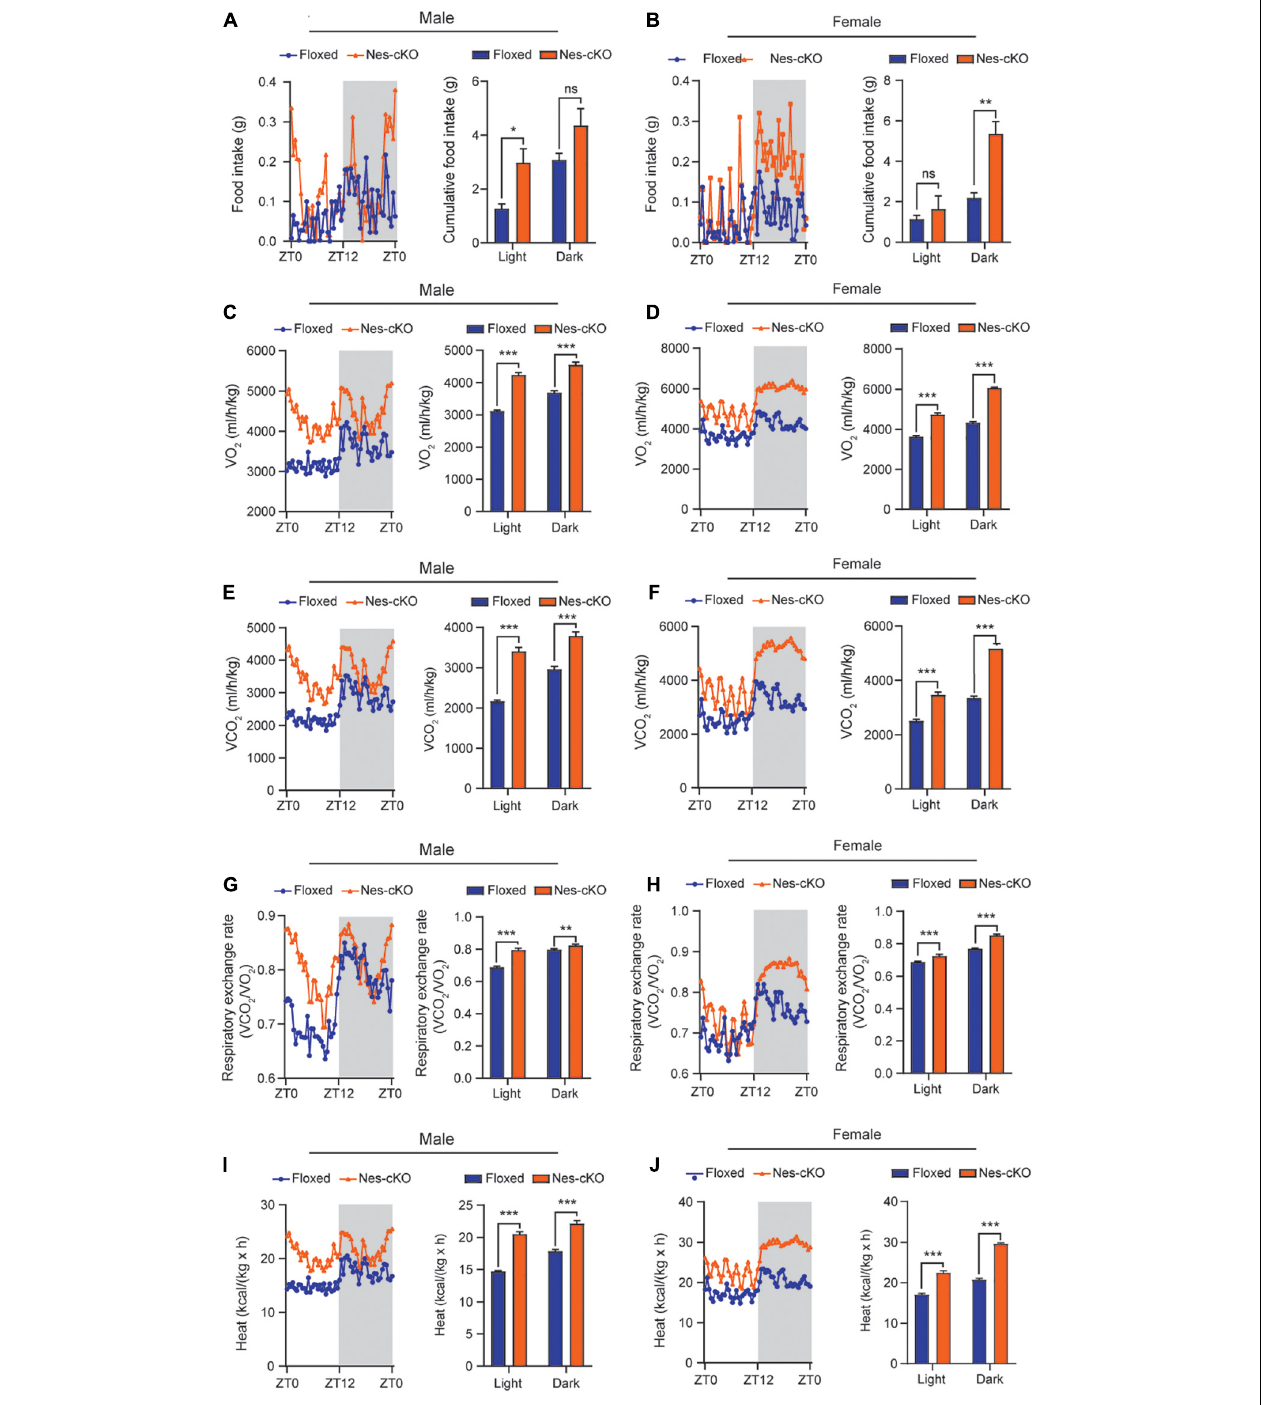
FIGURE 3 | Loss of Ash1l in the mouse brain causes metabolic hyperactivity. (A,B) Plots showing the food intake of male (A) and female (B) wild-type and Ash1l -Nes-cKO mice in the light-on cycle (ZT0–ZT12, Zeitgeber Time) and in light-off cycle (ZT12–ZT0). n = 4 males and four females per genotype. P -values calculated using two-way ANOVA tests. Error bars in graphs represent mean ± SEM. * p < 0.05; ** p < 0.01; ns, not significant. (C–J) Plots showing the oxygen (VO 2 ) consumption (C,D) , carbon dioxide (VCO 2 ) production (E,F) , respiration exchange ratio (VCO 2 /VO 2 ) (G,H) , and heat generation (I,J) of wild-type and Ash1l -Nes-cKO mice in the 12-h light-on cycle (ZT0–ZT12, Zeitgeber Time), and in the 12-h light-off cycle (ZT12–ZT0, Zeitgeber Time). n = 4 males and four females per genotype. P -values calculated using two-way ANOVA tests. Error bars in graphs represent mean ± SEM. ** p < 0.01; *** p < 0.001.